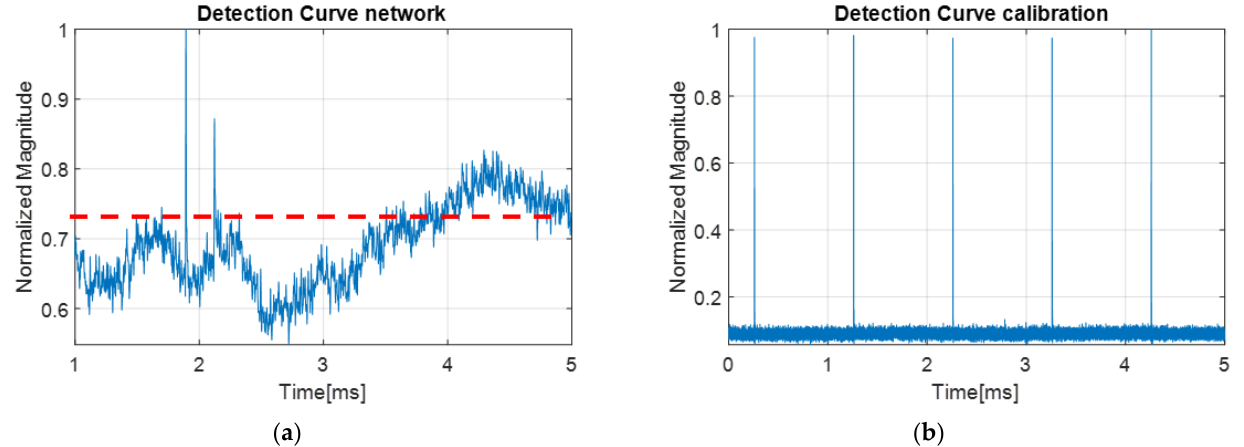
Figure 11. ( a ) Detection curve using spectrogram approach for the network signal; ( b ) detection curve using spectrogram approach for the calibration signal.